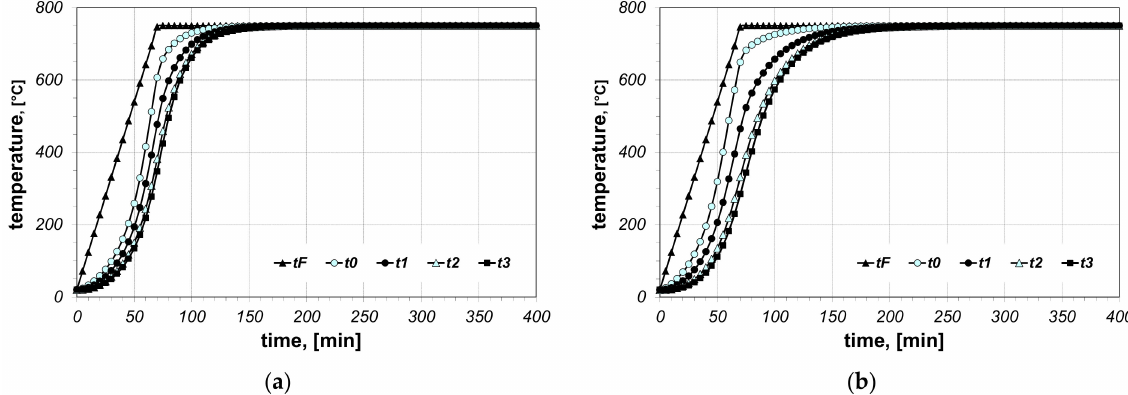
Figure 8. Calculated values of temperatures for heating of a 5 × 20 bar bundle with vertical arrangement: ( a ) results obtained for R ct-min , ( b ) results obtained for R ct-max